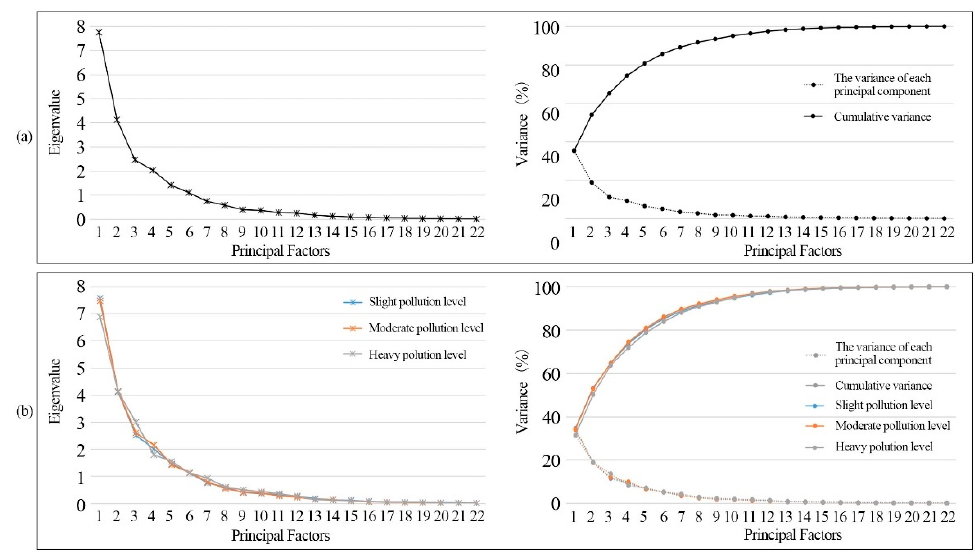
Figure 3. Variance and eigenvalue of principal factors at: ( a ) Overall pollution level; ( b ) Slight, moderate, and heavy pollution level.